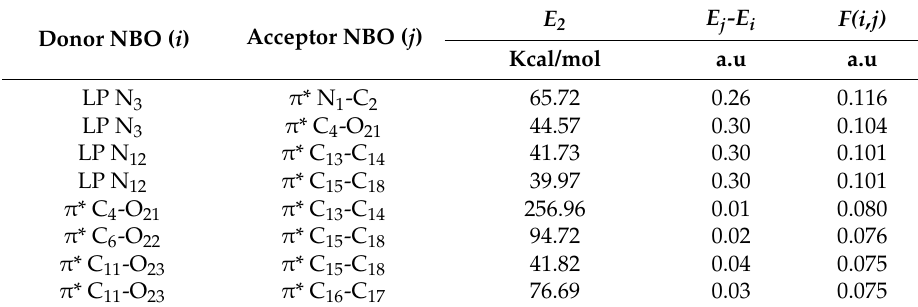
Table 7. Analysis perturbation theory second order in Fock matrix in NBO by level calculation B3LYP/6-31G (d,p) for compound 4c